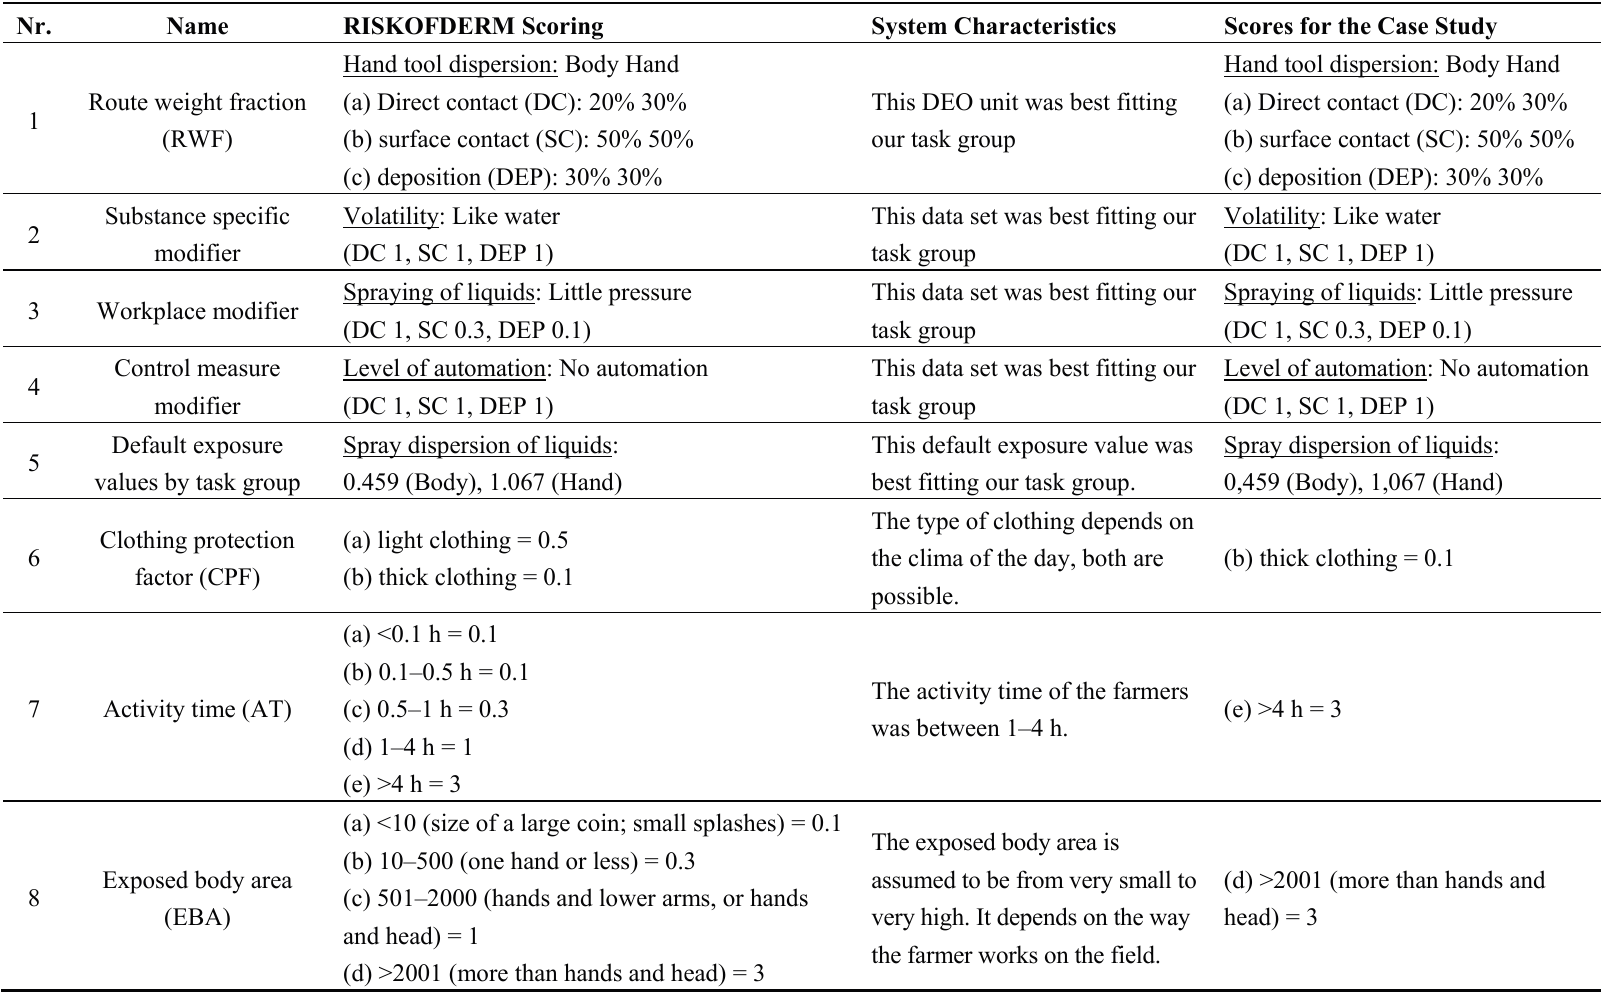
Table A4. RISKOFDERM Scoring System for the Case